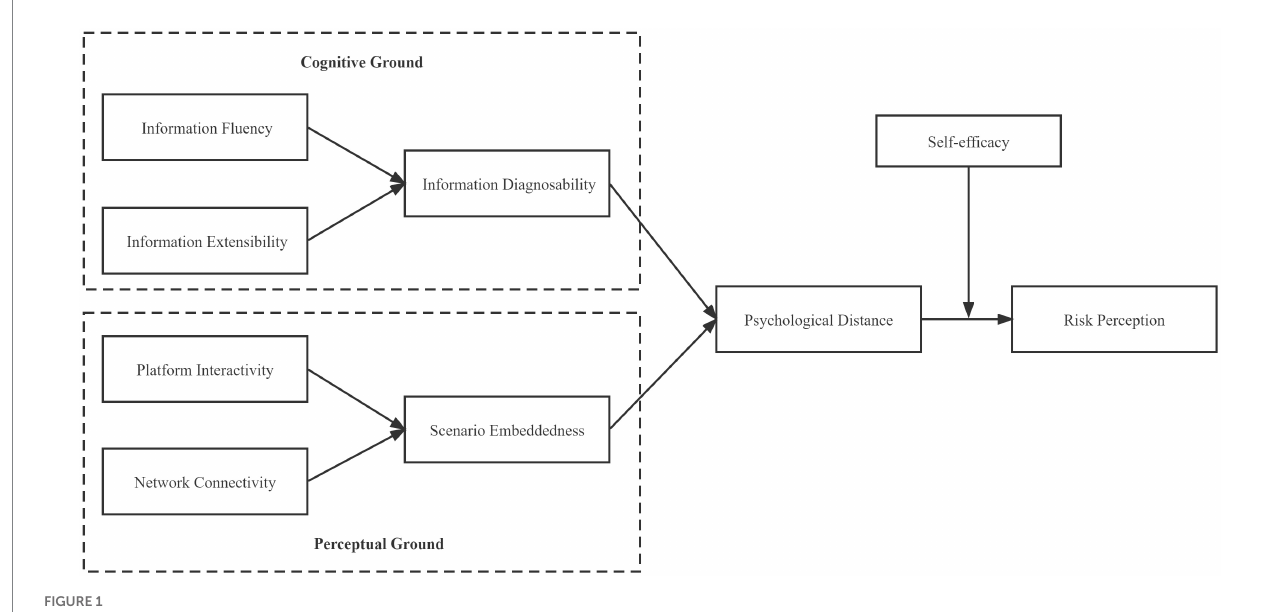
FIGURE 1 Research